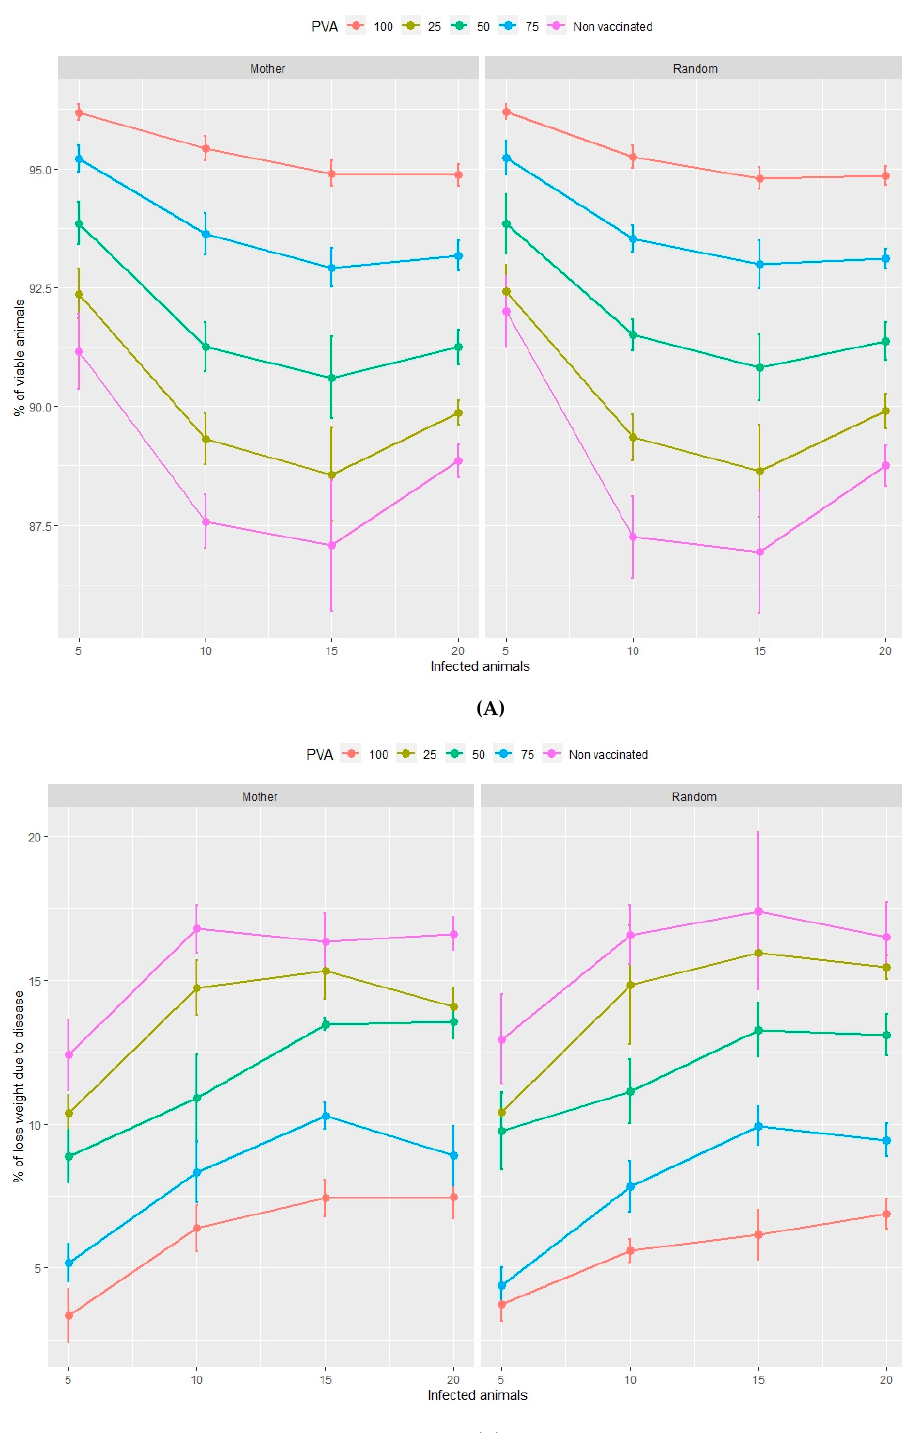
Figure 1. Percentage of viable animals ( A ) and percentage of total weight lost ( B ) at the end of the nursery period in relation to the type of management (mother or random), the percentage of vaccinated animals (PVA—ranging from 0–100% of the population) and the percentage of infected animals at the time of vaccination. Orderly movements of piglets consist of allocating them to nursery pens according to the identity of their mothers and then filling the fattening pens according to the same nursery distribution (Mother) c.f. random movements whereby piglets are allocated to both nursery and fattening pens at random (Random).